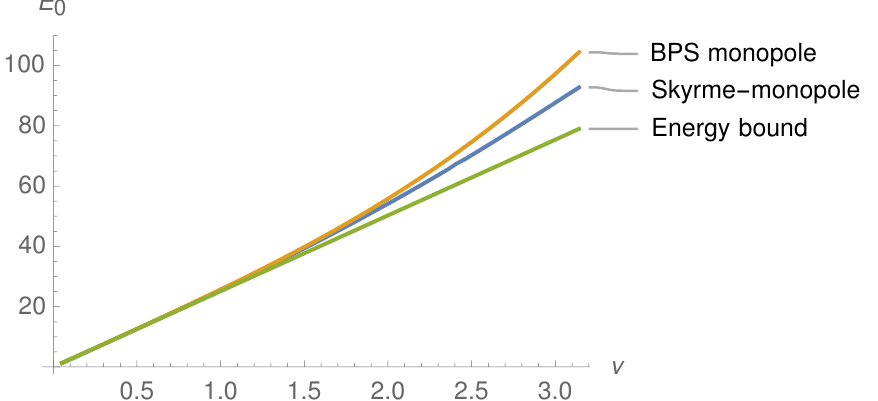
Figure 2. The energies of the Skyrme-monopole (blue), monopole approximation (orange), and the topological absolute minimum (green), for (cid:23) 2 (0 ; (cid:25) ]. Again we expect the asymptotic solution to take the form g = de (cid:31)r r p . Substituting